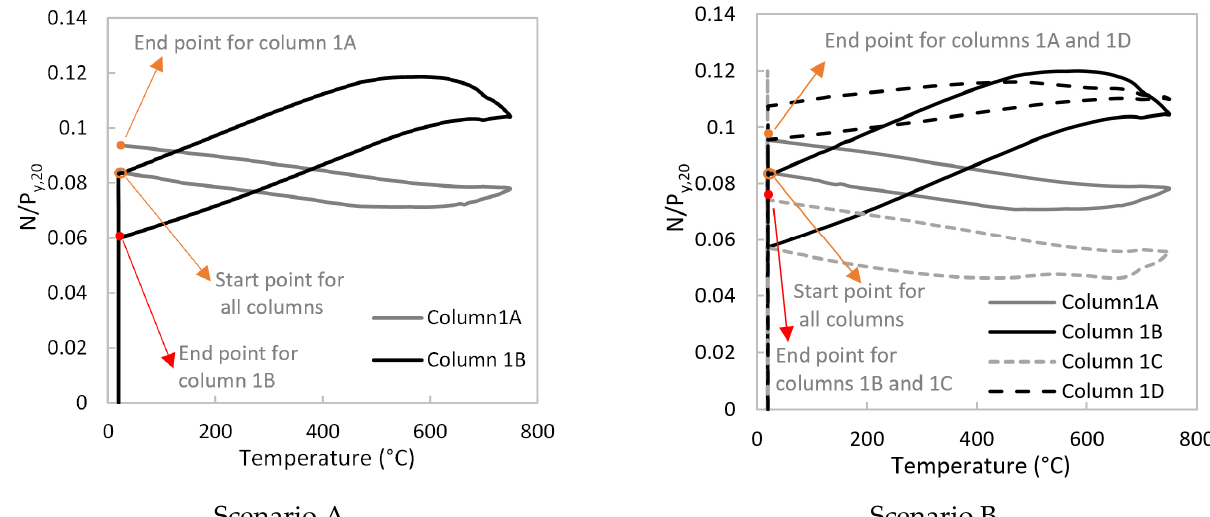
Figure 20. Normalized axial forces for the heated columns during fire. The post-fire deformed shape of the left bay of the frame is presented in Figure 21 (Scenario A). It is observed that the beam is severely damaged, while the columns are slightly damaged. Small web and flange out-of-plane displacements are detected for the heated columns and the global out-of-plane displacements are minor as well (Figure